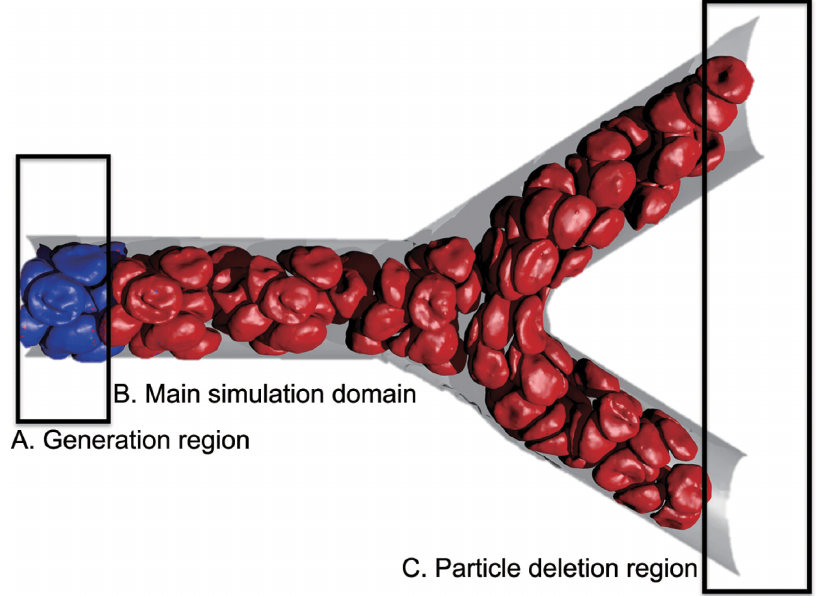
Fig 1. Simulation of blood flow in a microvascular bifurcation using the proposed open boundary conditions. The simulation domain is subdivided into three regions: (A) generating region with fully developed flow; (B) the main simulation domain; (C) the outlet region where particles are deleted. Fluid particles and frozen wall particles are not shown for